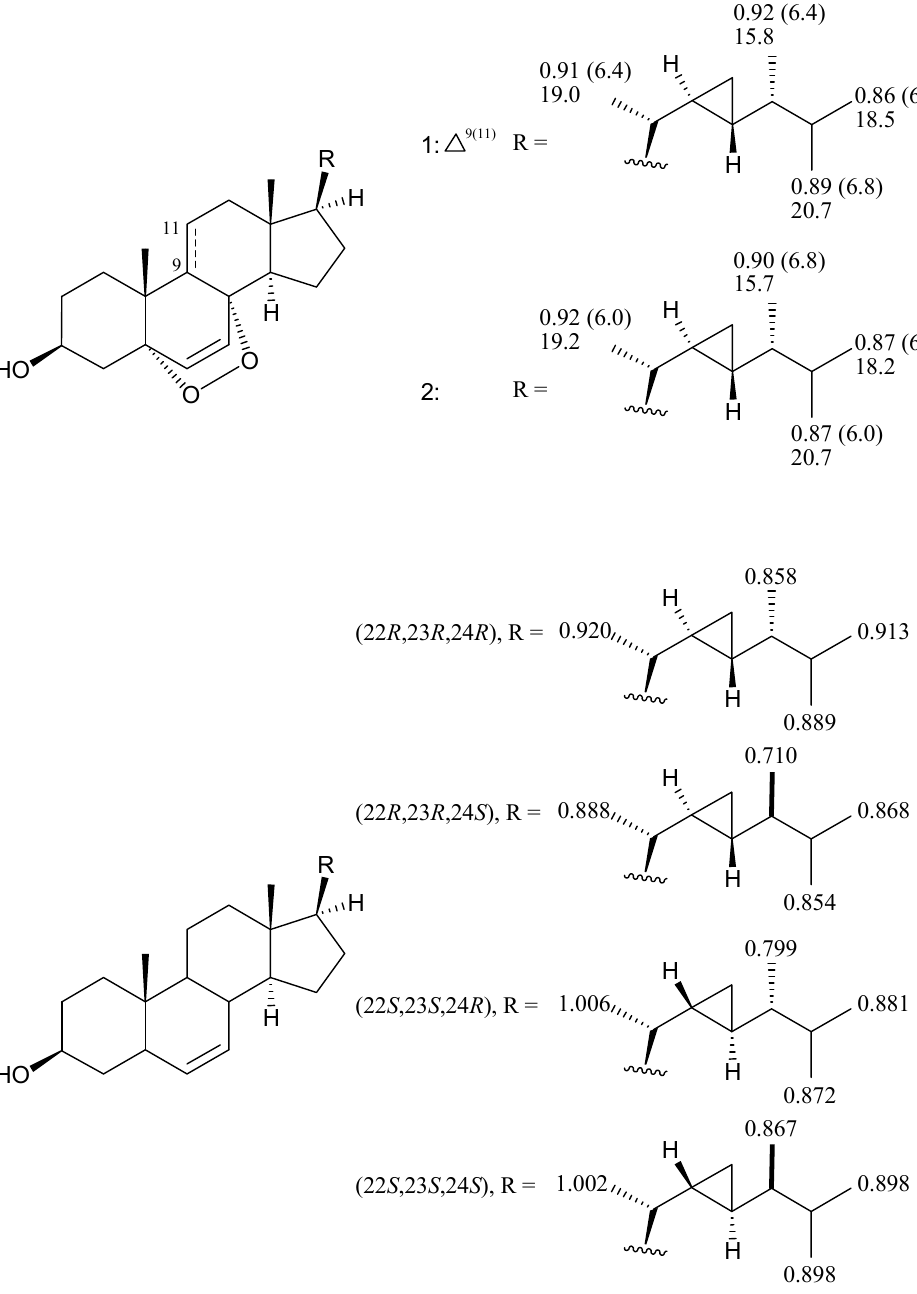
Figure 3. The 1 H and 13 C-NMR chemical shifts of the side-chain methyl groups of epidioxysterols 1 and 2 and synthetic isomers of demethylgorgosterols